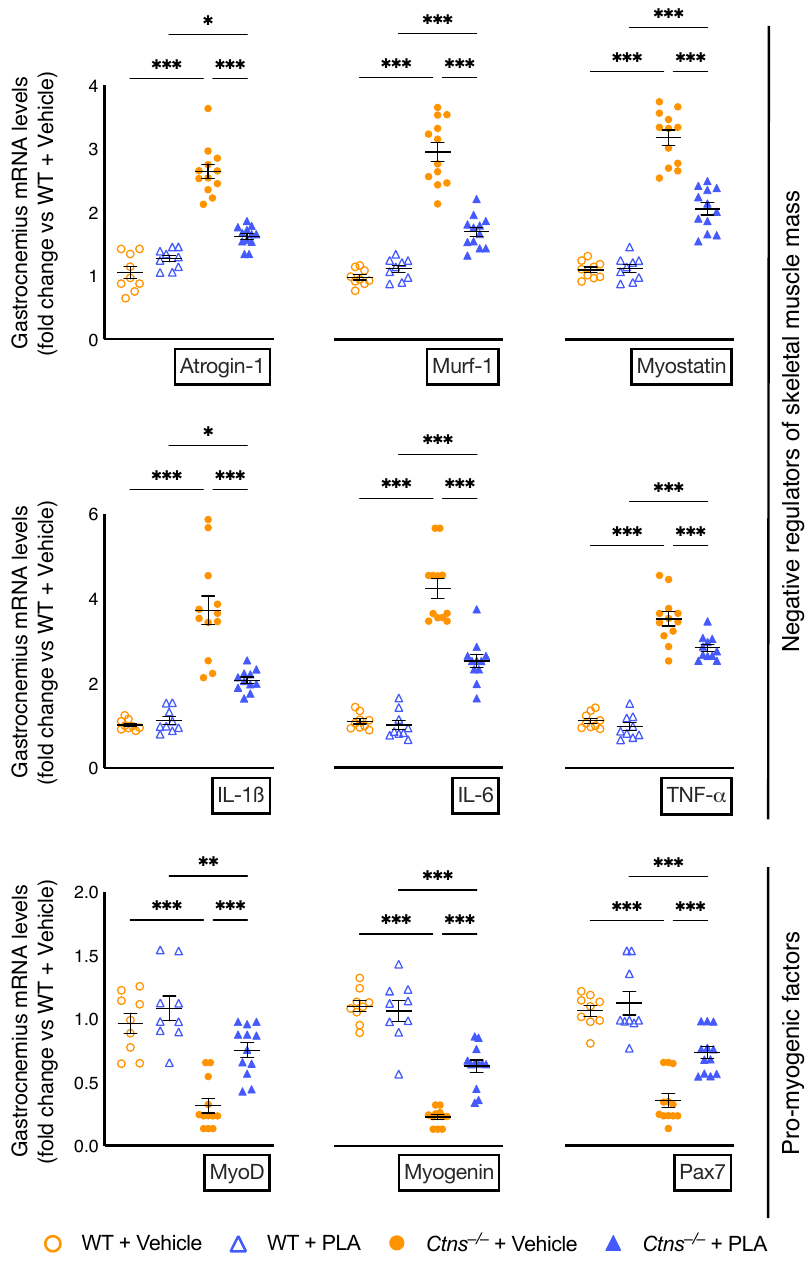
Figure 4. PLA attenuates signaling pathways implicated in muscle wasting in Ctns − / − mice. Gastrocnemius muscle expression of negative regulators of skeletal muscle mass (Atrogin-1, Murf-1, Myostatin, IL-1β, IL-6 and TNF-α) as well as pro- myogenic factors (MyoD, Myogenin and Pax7) were measured by qPCR. Final results were expressed in arbitrary units, with one unit being the mean level in vehicle-treated WT mice. In addition, results of PLA-treated Ctns −/− mice were com- pared to vehicle-treated Ctns −/− mice and specific p -values are shown above the bar. * p < 0.05, ** p < 0.01, *** p < 0.001.